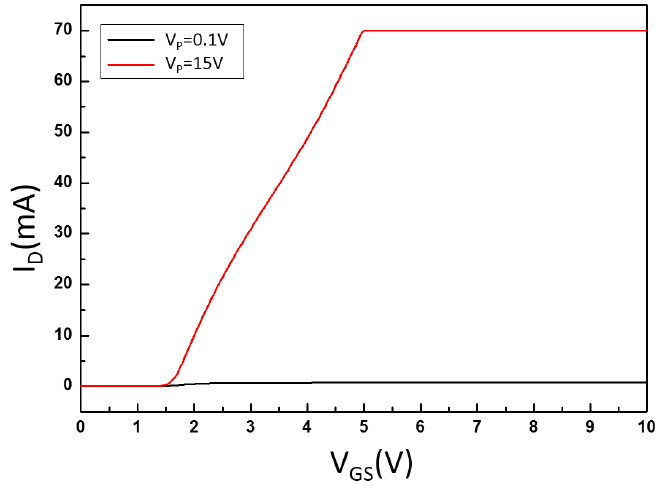
Figure 15. Threshold voltage of MOS driver. Micromachines 2017 , 8 , 346